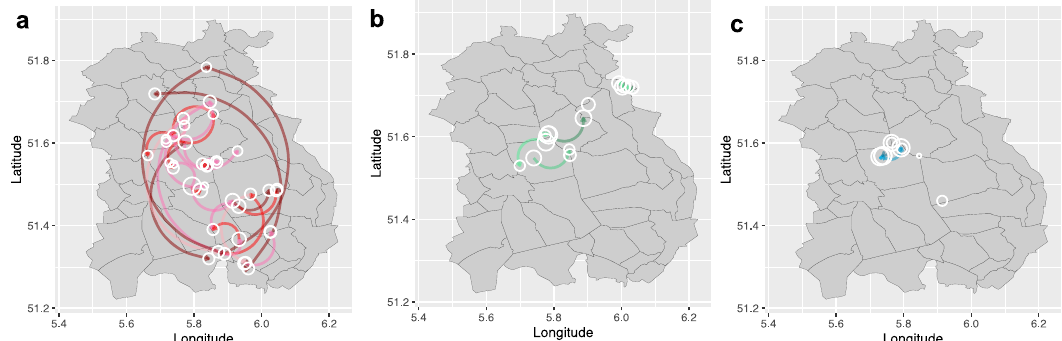
Fig. 7 Transmission network between farms on map inferred from phylogenies of 3 mink clusters. a Cluster A, b Cluster C and c Cluster D. The locations of farms on the map have been jittered for privacy reasons. Size of nodes indicates number of samples; arrow on edge indicates transmission direction; colour of edge from light to dark indicates Bayes Factor (BF) support from low to high (only transmissions with BF >3 are shown), colour keys are the same as Fig.